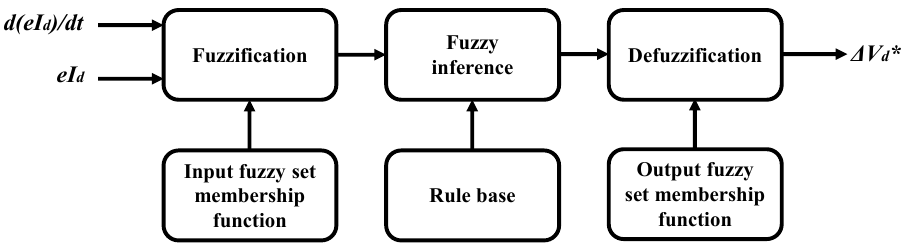
Figure 6. Structure of the proposed FLC.